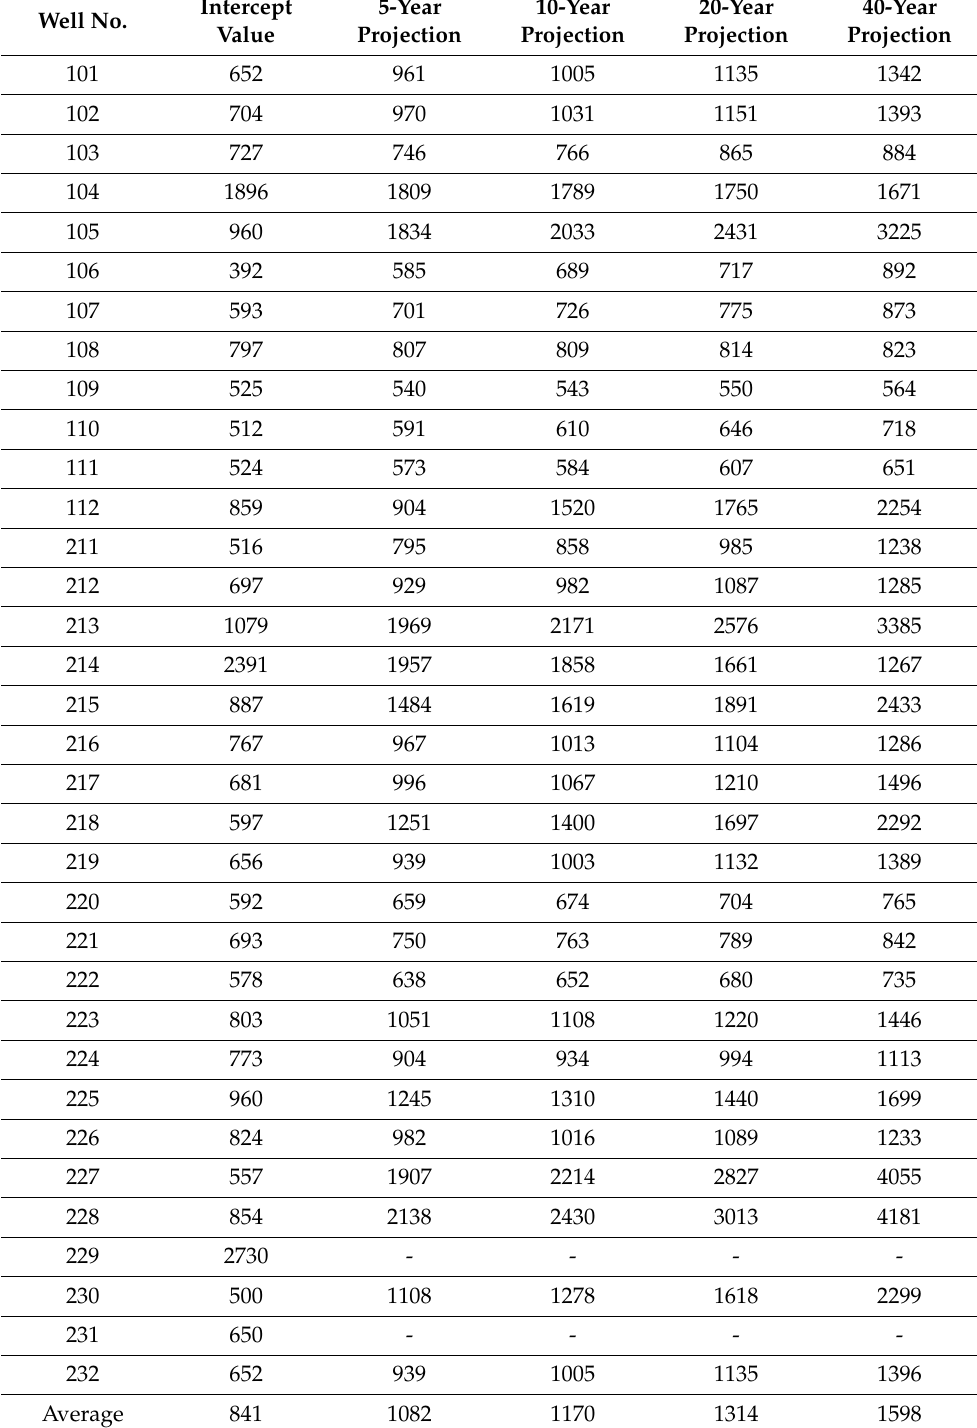
Table 3. Initial dissolved chloride concentration value in mg/L for March 2021 and projected values for 5, 10, 20, and 40